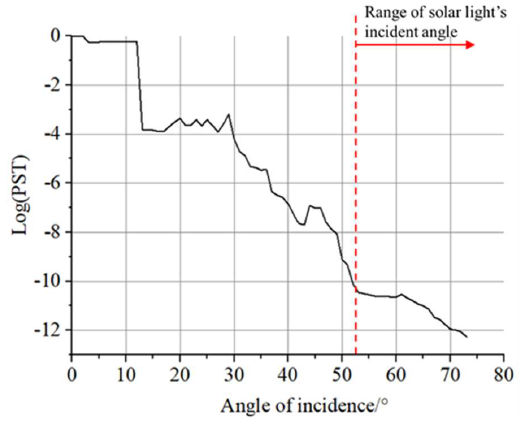
Figure 13. PST curves of the camera.